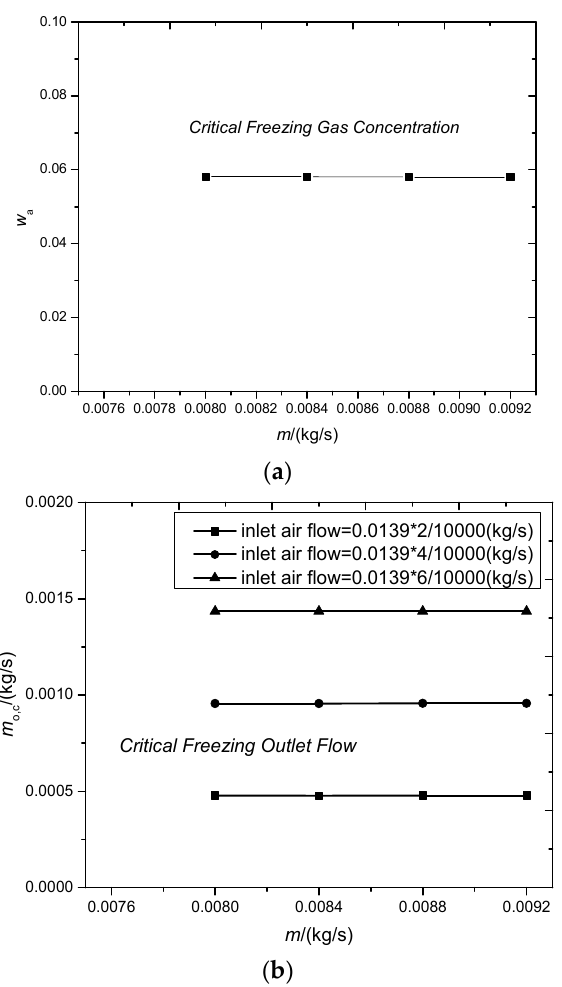
Figure 9. ( a ) Critical freezing gas concentration versus inlet steam flow; ( b ) Critical freezing outlet flow versus inlet steam flow.